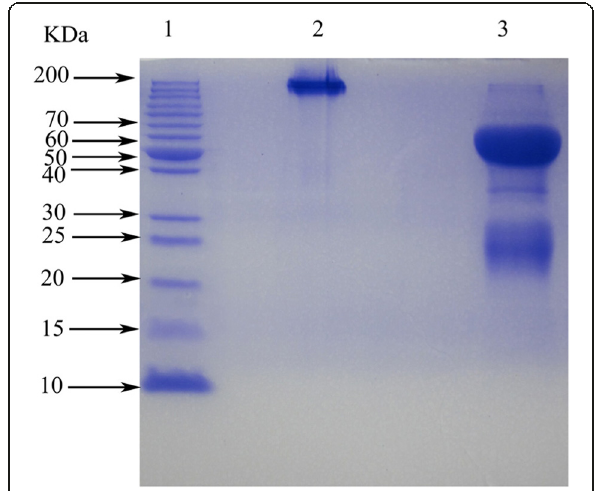
Fig. 2 SDS-PAGE analysis (10 % resolving gel) of anti- T. albolabris IgY. Lanes: (1) molecular weight marker; (2) non-reduced IgY; and (3) reduced IgY